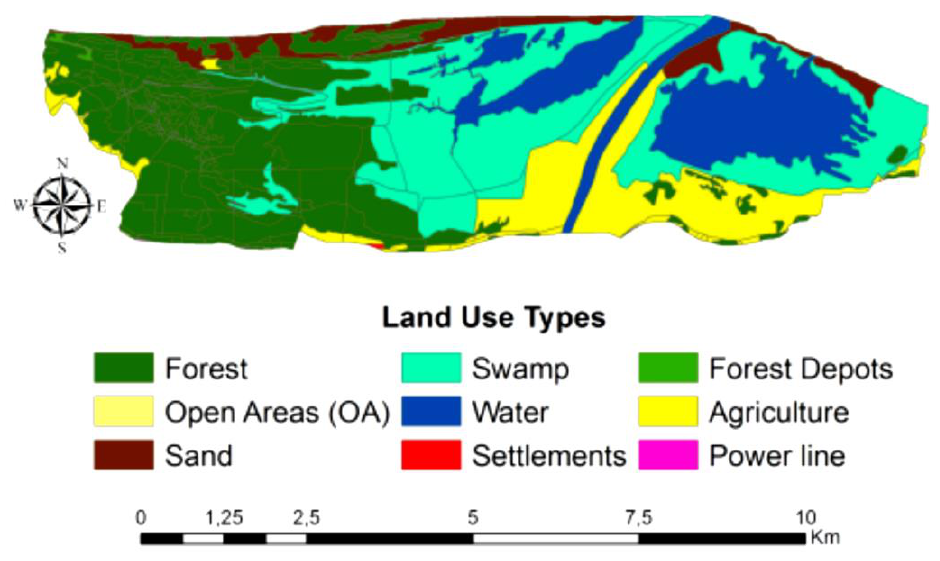
Figure 3. Forest management map based land use